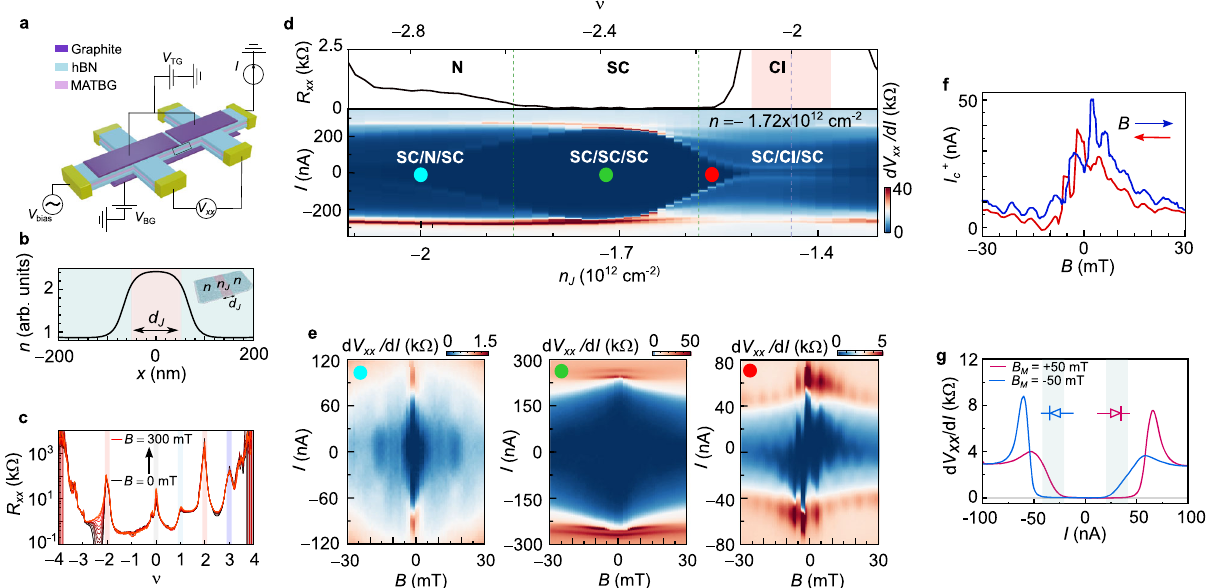
Fig. 1 | Gate-tunable JJ in MATBG. a Schematic of the measured device and mea- suring circuit, where V bias isthe source voltage, I isthe current through the device, V xx the voltage drop between the measurement probes, and V BG ( V TG ) correspond to the back (top) gate voltage. The top graphite gates are separated by 150nm. b Electrostatic simulation pro fi le of carrier density n vs. position x , setting n and carrier density in the junction n J at different values with a junction length d J of 100nm. The inset shows a schematic of the MATBG JJ with two distinct regions createdbythegatingstructure. c Fourterminallongitudinalresistance R xx vs. fi lling factor υ at different out-of-plane magnetic fi elds B from 0mT (black curve) to 300mT (red curve). d (Top) Magni fi cation of c around the superconducting state − 3< υ < − 1.8, where we de fi ne three distinct regions with metallic (N),